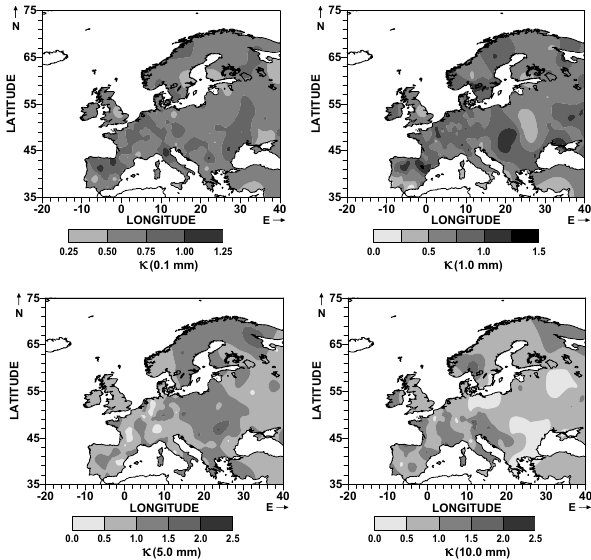
Fig. 10. Spatial distribution of the Kolmogorov entropy for thres- holds of 0.1, 1.0, 5.0 and